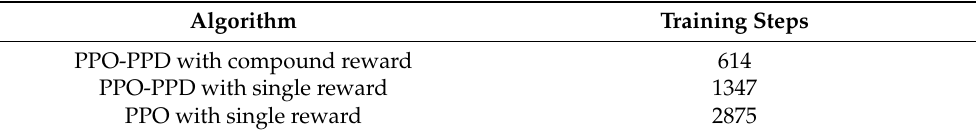
Table 4. Training steps to reach 220 threshold.